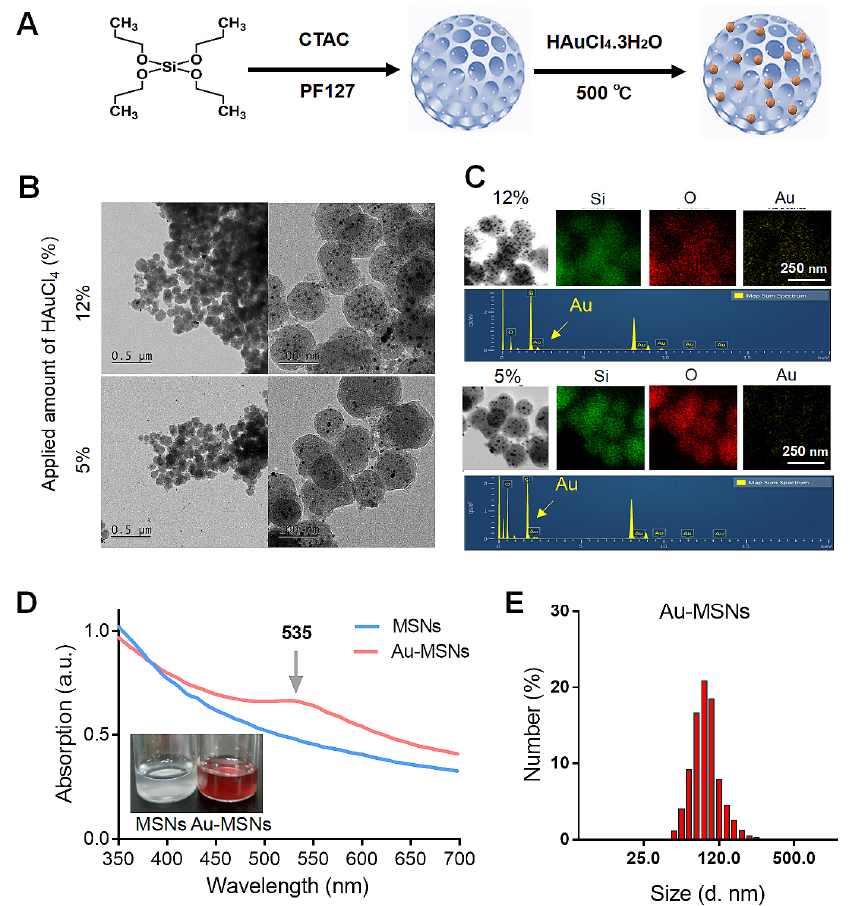
Figure 1. Characterizations of Au-MSNs. ( A ) Schematic illustration for synthesis of Au-MSNs. ( B ) Transmission electron microscopy (TEM) images of Au-MSNs (scale bar = 100 and 500 nm). ( C ) TEM and energy-dispersive X-ray spectroscopy (TEM EDX) mapping images of Au-MSNs with 5 wt% (50 μ g/mL) or 12 wt% (120 μ g/mL) of HAuCl 4 .3H 2 O for Au, Si, and O, respectively. ( D ) Ultraviolet–visible (UV-vis) absorption spectra of MSNs and Au-MSNs. ( E ) Dynamic light scattering (DLS) measurement of Au-MSNs.